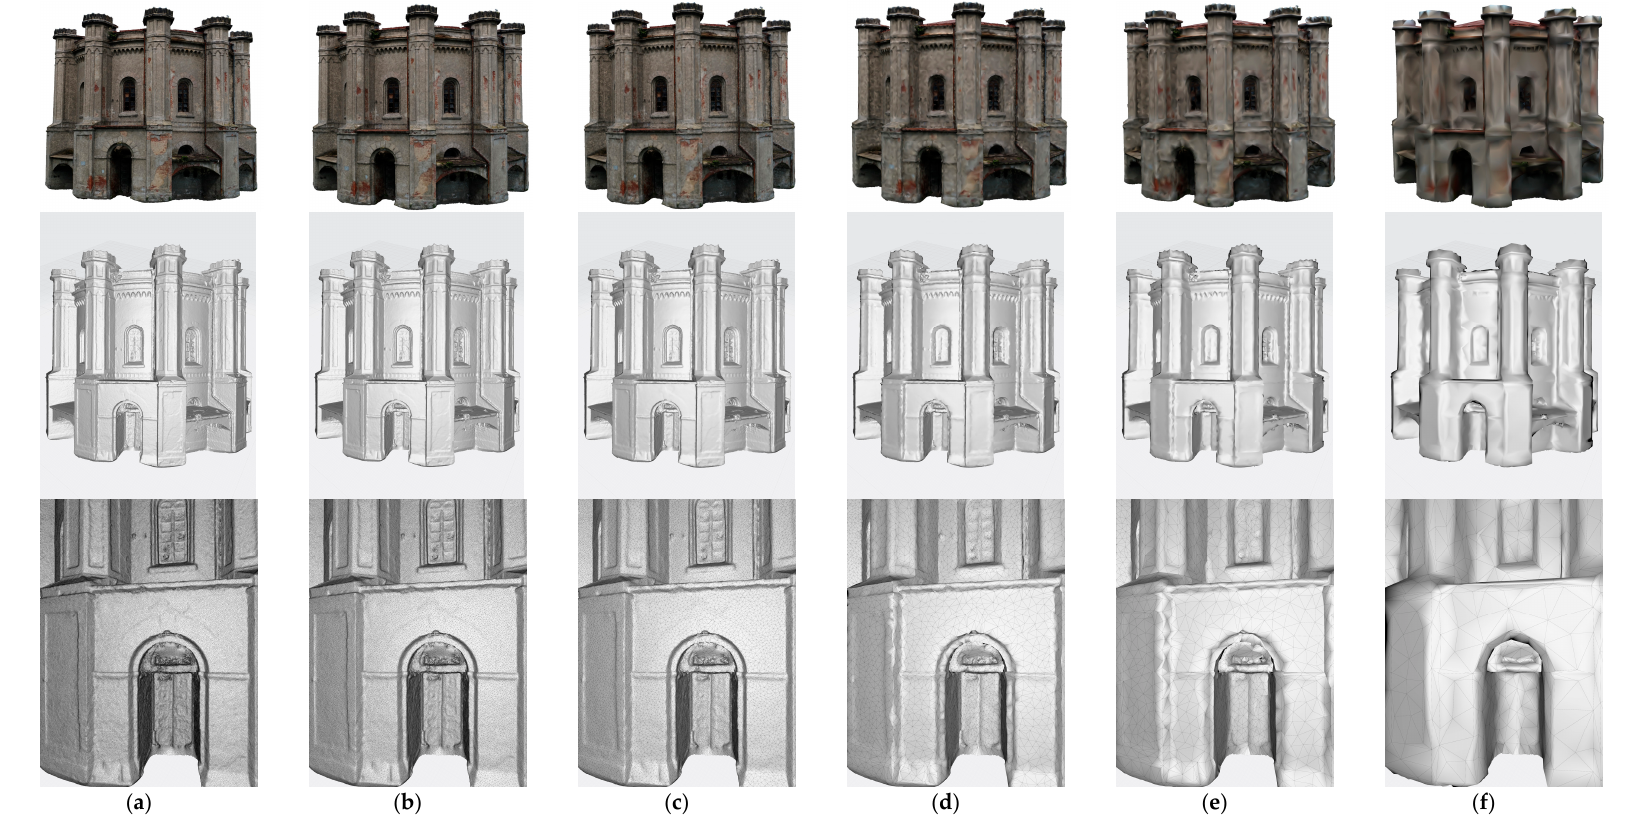
Figure 13. Comparison of mesh models of Water Tower building: ( a ) High quality model. ( b ) Medium quality model ( c ) Low quality model ( d ) 250 k quality model ( e ) 100 k quality model ( f ) 25 k quality model (top—models with textures, middle—solid model, bottom—models with triangles (bottom part of building with door)).